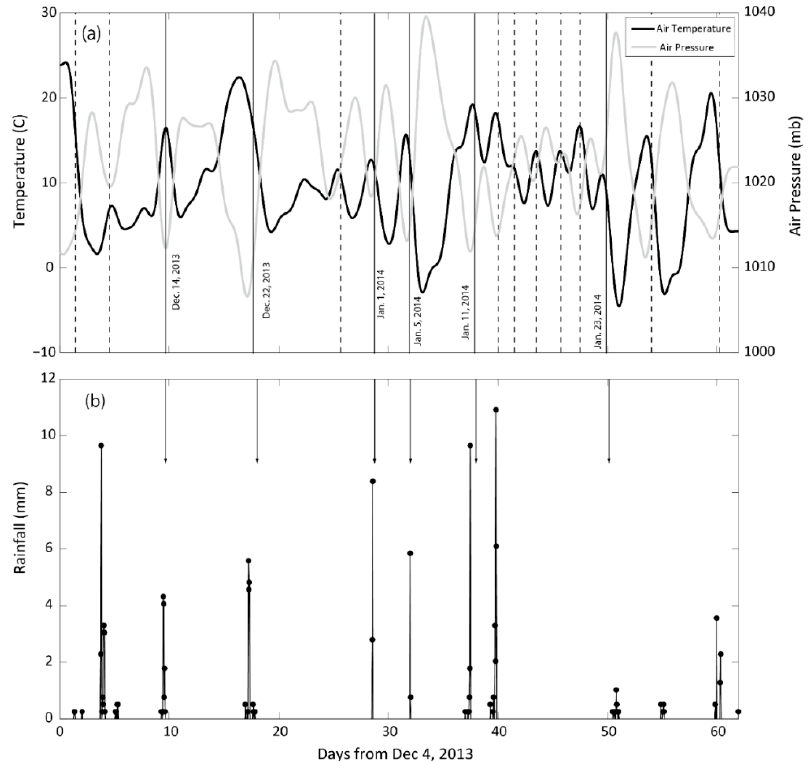
Figure 5. Weather conditions (temperature and air pressure) ( a ) from station LCLL1 (30.2236° N 93.2217° W); the black line is temperature and the gray line is air pressure; the vertical lines indicate the timing of an atmospheric frontal passage; the six major events were labeled with the time of frontal passage; ( b ) hourly precipitation (mm) from Lake Charles station at (30.1247° N, 93.2283° W); the arrows indicate the timing of the major frontal passages.